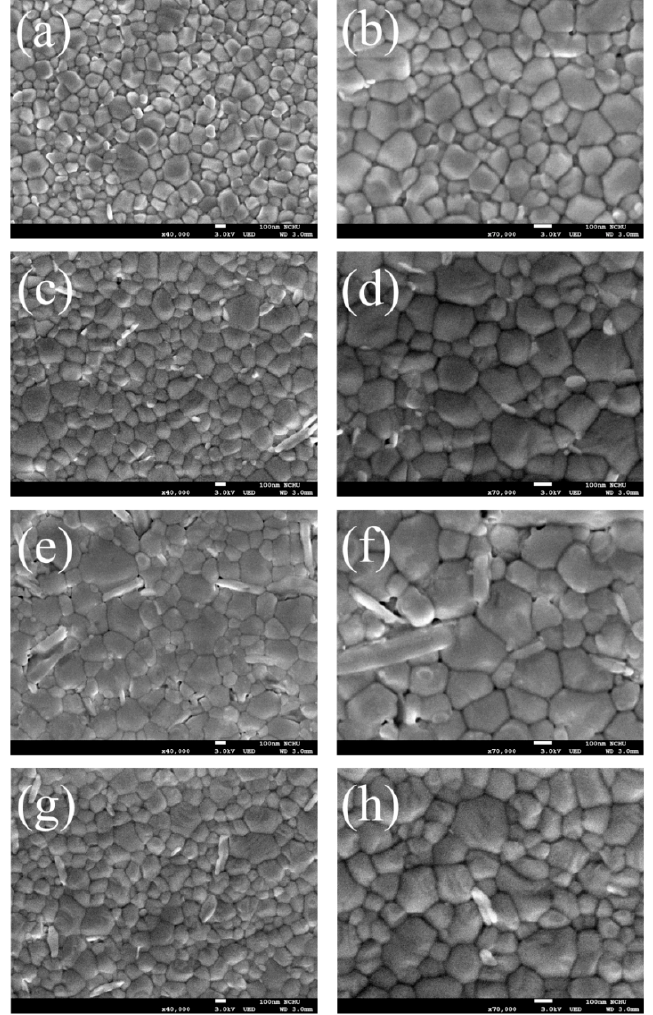
Figure 2. SEM images of MAPbI 3 layer incorporated with various h-TAc contents: ( a , b ) 0, ( c , d ) 75, ( e , f ) 85 and ( g , h ) 100 wt%. Scale bar: 100 nm.